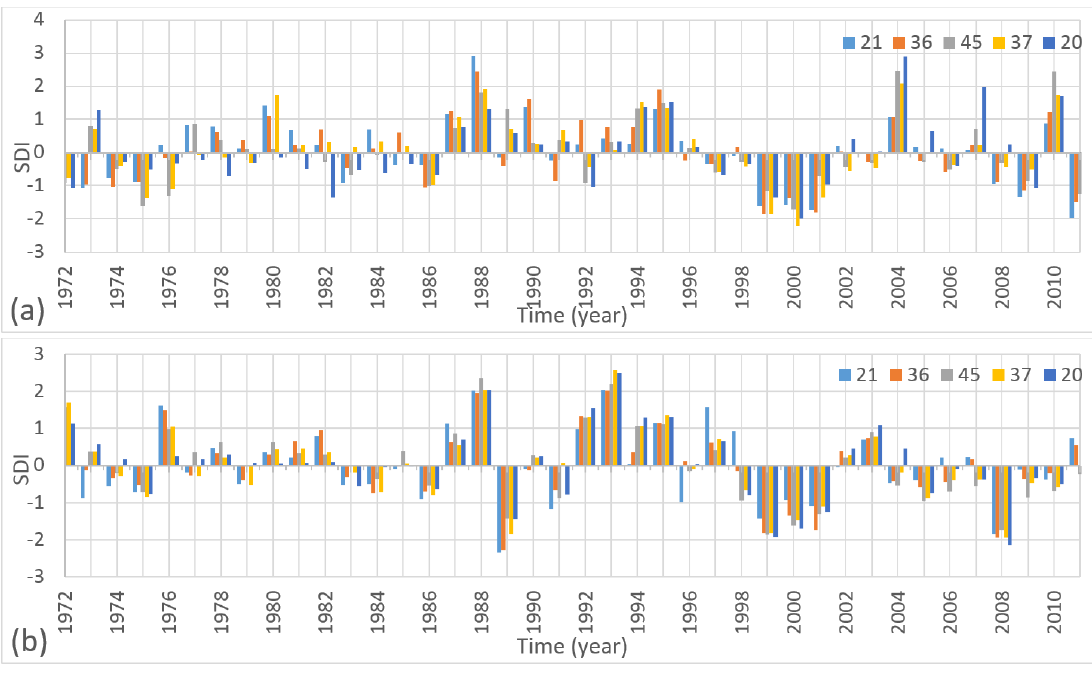
Figure 7. SDI-6 series of the stations 21, 36, 45, 37, and 20 for the periods of ( a ) October – March and ( b ) April – September.